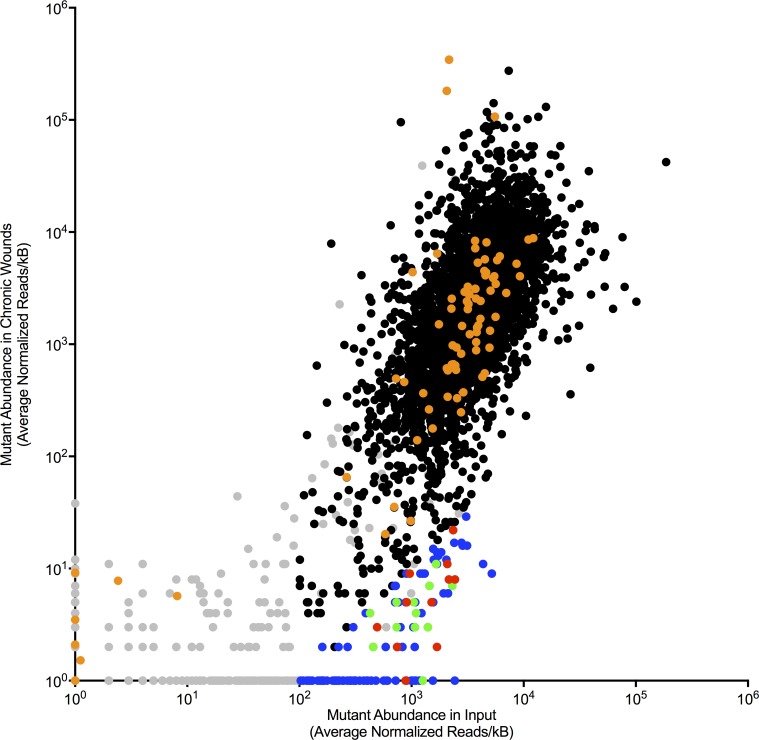
Identification of gene inactivations that compromise wound fitness.Tn-seq measured the relative change in abundance of mutants in the inoculum (x-axis) and after infection (y-axis). Each point represents a different gene inactivation. Gray points indicate gene inactivations with low input abundance; orange points indicate virulence genes [29]; blue, green and red points indicate gene inactivations exhibiting significant (P<0.01) decreases in abundance after infection. Green and red points indicate gene inactivations tested in 1:1 experiments (see Fig 4); gene inactivations indicated by green points were verified to be wound-defective, while gene inactivations indicated by red points were not defective in verification experiments. Gene inactivations indicated by blue points were not tested in 1:1 competitions.